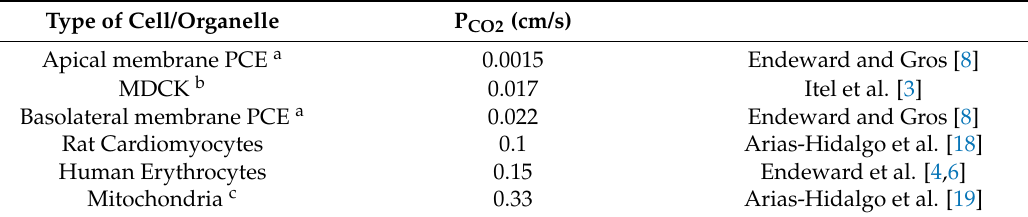
Table 1. CO 2 permeabilities of cells and organelles of various mammalian